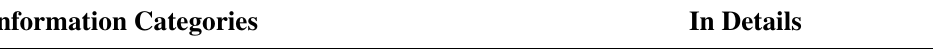
Table 1. Brief contents of